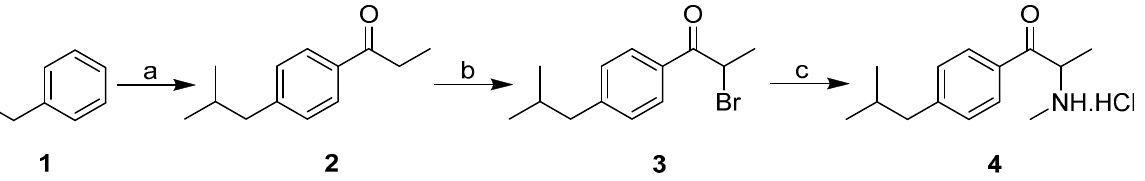
Figure 2. General synthesis of 4-isobutylmethcathinone ( 4 ), reaction conditions: ( a ) propionyl chloride, AlCl 3 , CH 2 Cl 2 , 0 °C, 1 h; ( b ) CuBr 2 , EtOAc, reflux, 4 h; ( c ) NH 2 CH 3 , THF, room temperature, 4 h, then aq. HCl.